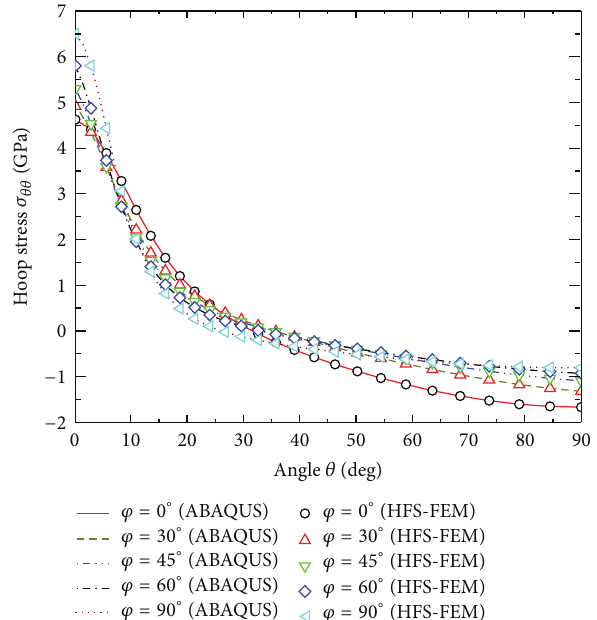
Figure 18: Variation of hoop stresses along the rim of the elliptical hole for different fiber orientation 𝜑